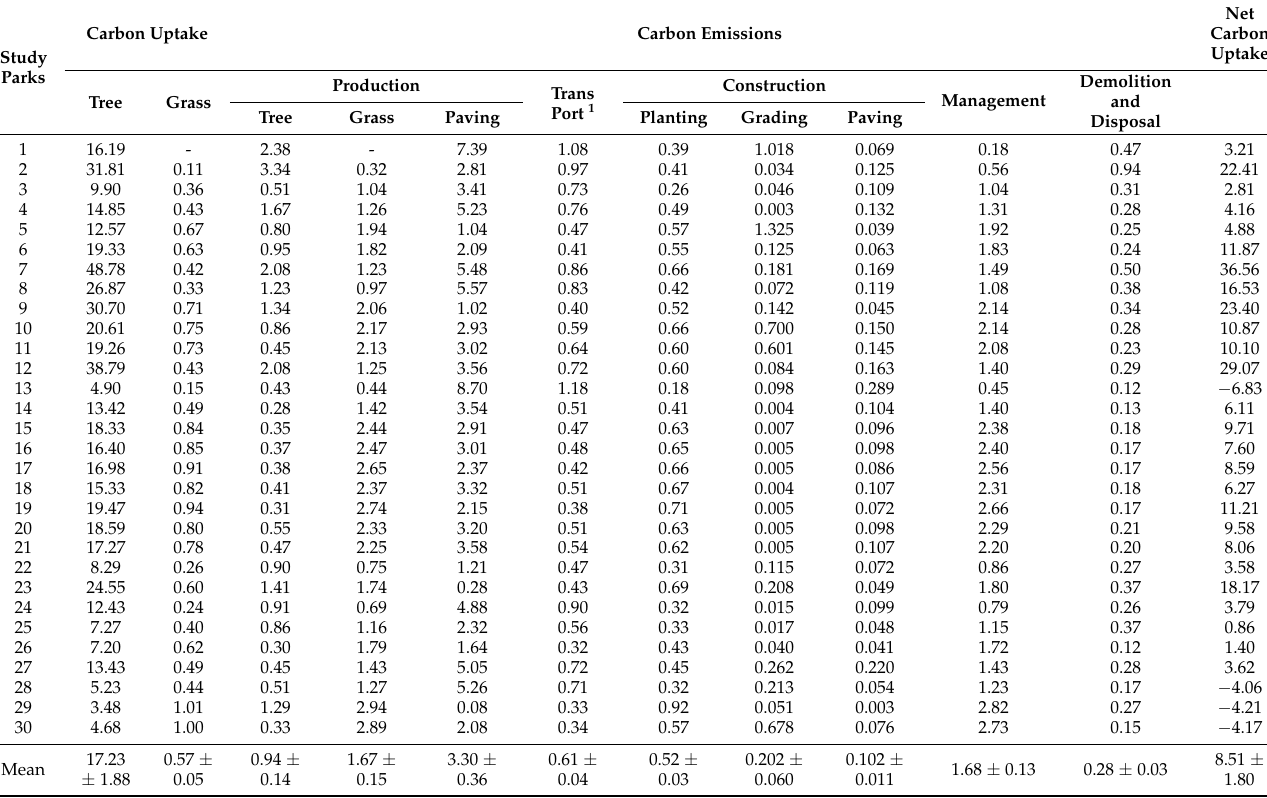
Table 11. Carbon budget per unit area over the life cycle of study parks (kg/m 2 ).